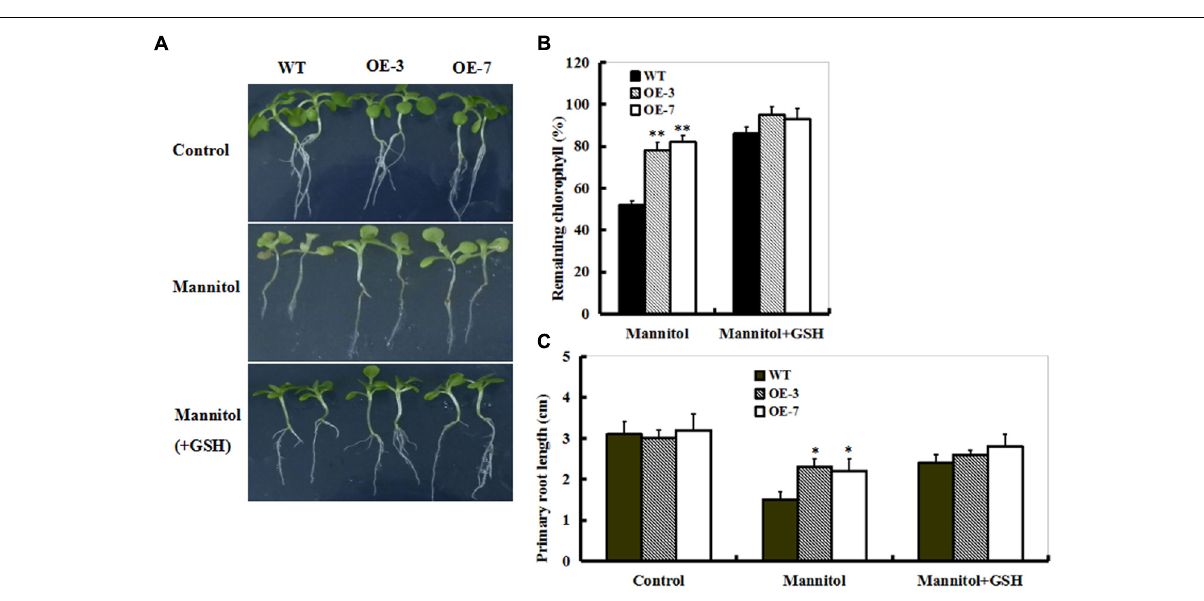
significant increase between the WT and OE plants ( Figure 7